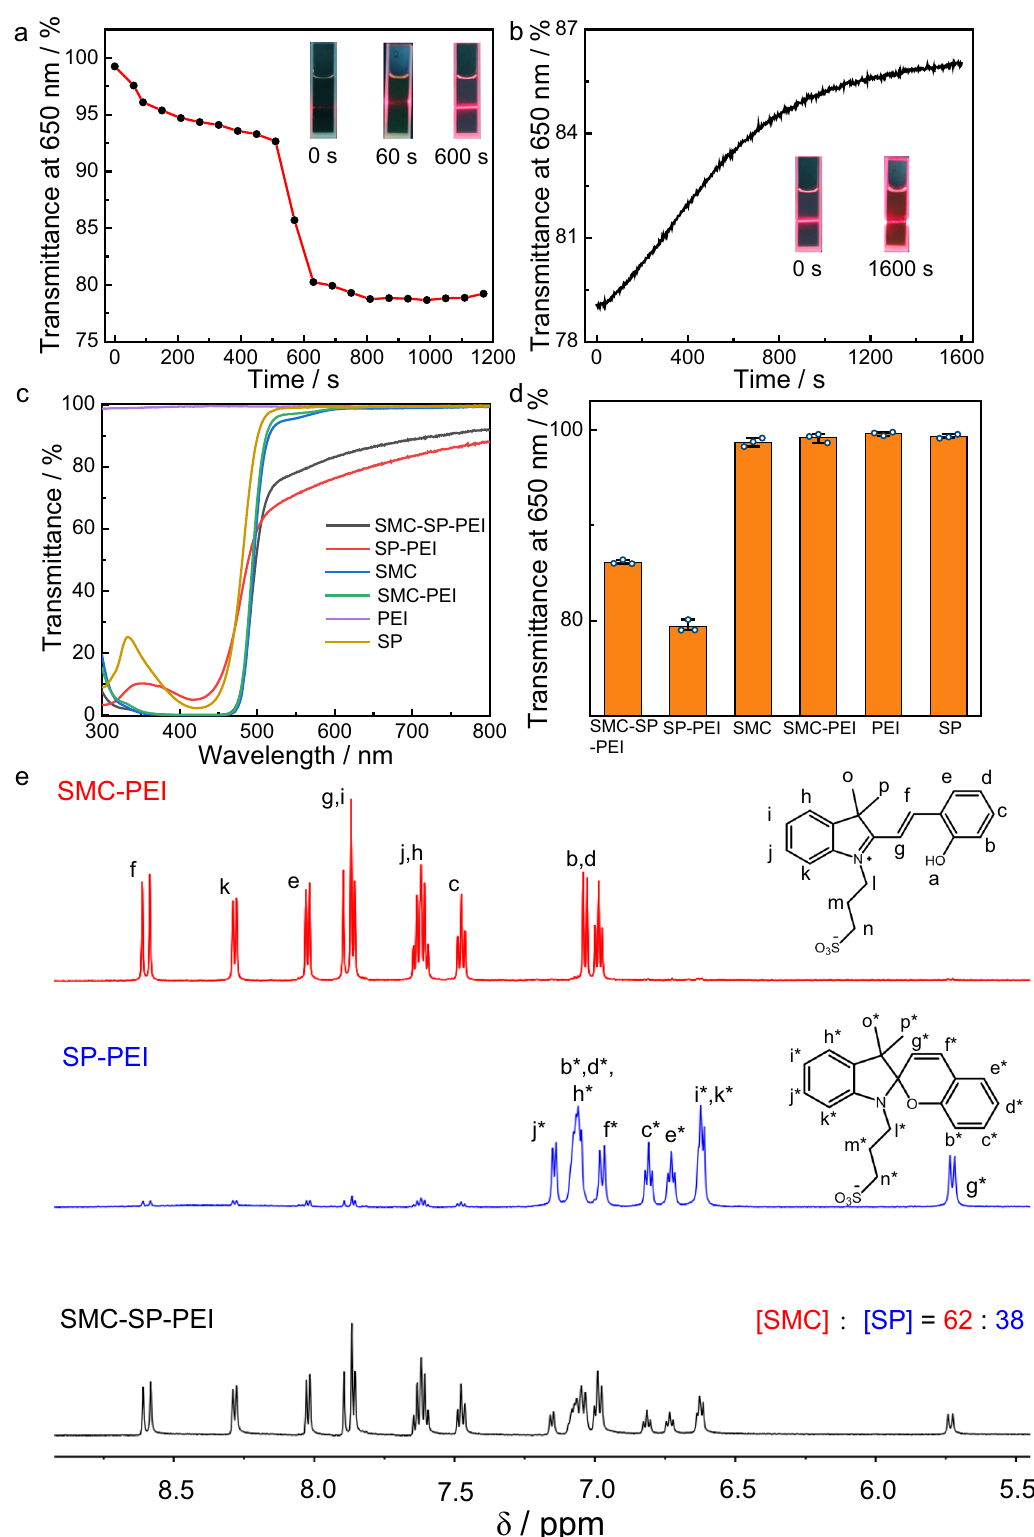
Fig. 2 Construction of the light-activated supramolecular DSAs. a Decrease process of transmittance at 650 nm of SMC-PEI under 420 nm irradiation from 0 s to 1170 s. Inset: Tyndall effect photos at different irradiation time. b Optical transmittance at 650 nm during thermal deformation process of SP-PEI over time. Inset: Tyndall effect photos after different time in the dark. c Transmittance spectra of SMC-SP-PEI, SP-PEI, SMC, SMC-PEI, PEI, SP solutions. d Transmittance at 650 nm of c and the corresponding cubic error bars. n = 3 independent experiments, with the bar data indicating mean ±